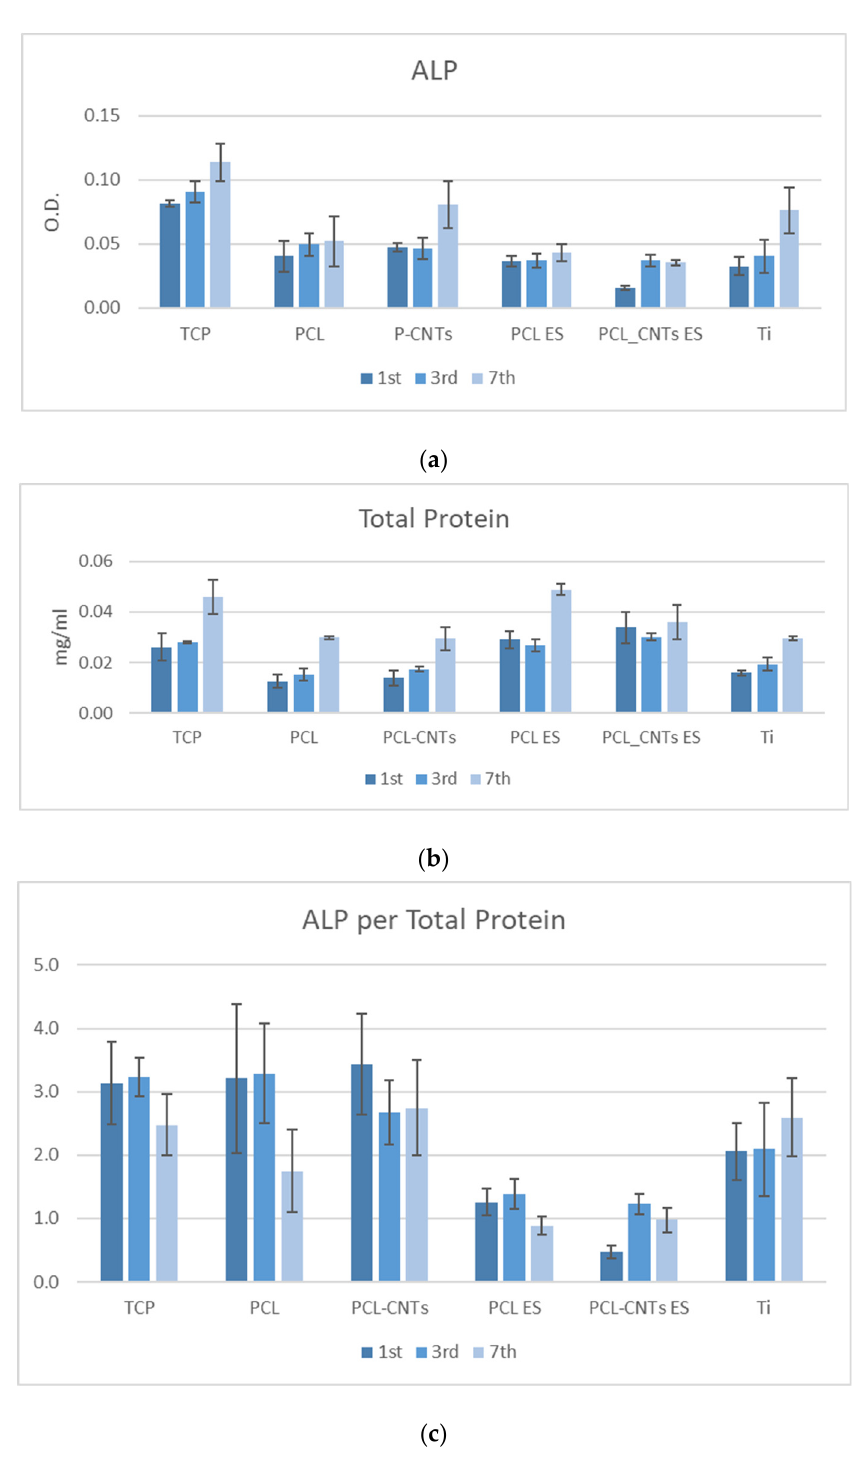
Figure 8. Levels of ( a ) alkaline phosphatase, ( b ) total protein, and ( c ) alkaline phosphatase per total protein in cells after 1, 3, and 7 incubation days. protein in cells after 1, 3, and 7 incubation